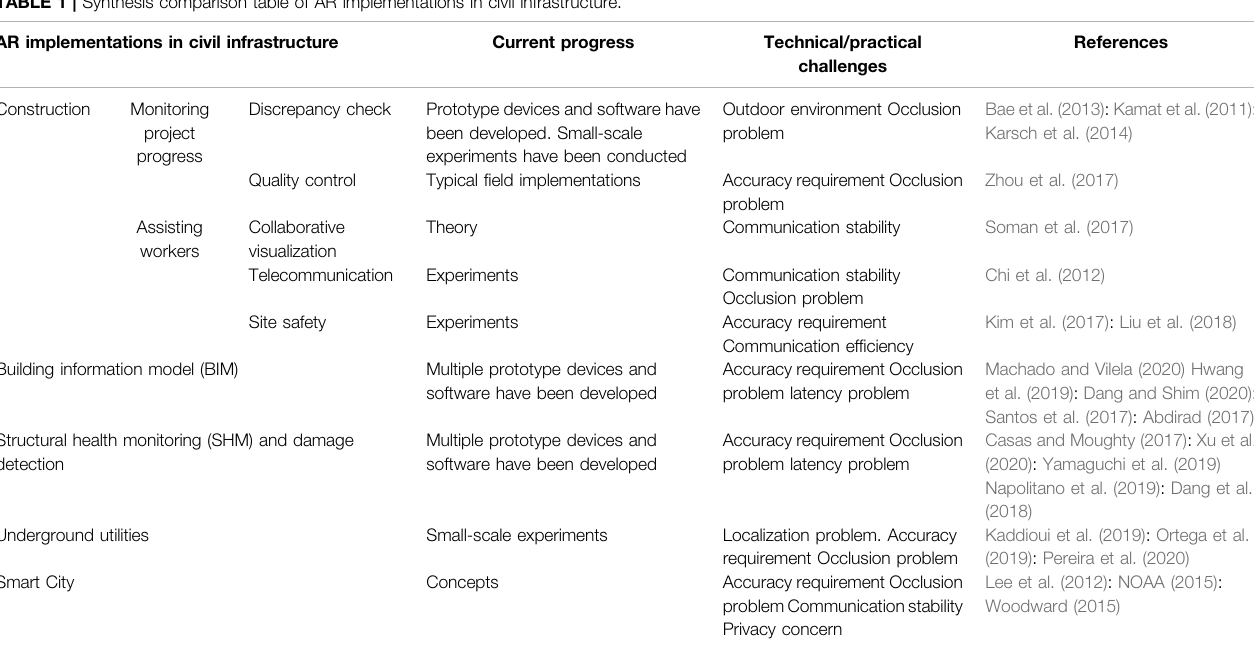
TABLE 1 | Synthesis comparison table of AR implementations in civil